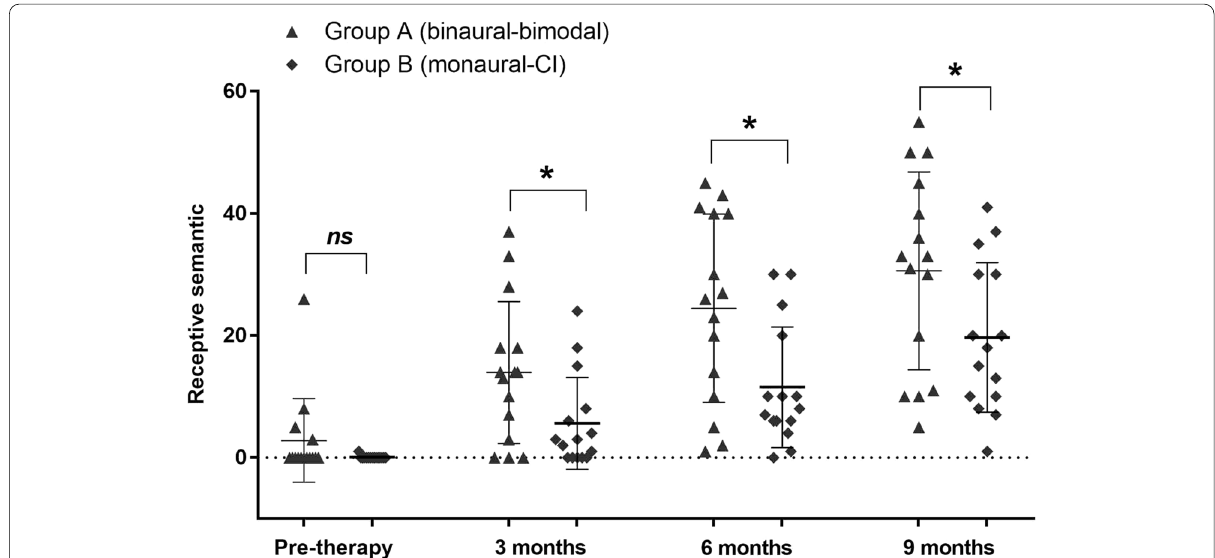
Fig. 1 Comparison of the receptive semantics between group A and group B. Results of unpaired t ‑test (two tailed) revealed better receptive semantic in the group A (bimodal) over time. CI, cochlear implantation; ns, nonsignificant, *significant ( P < 0.05)